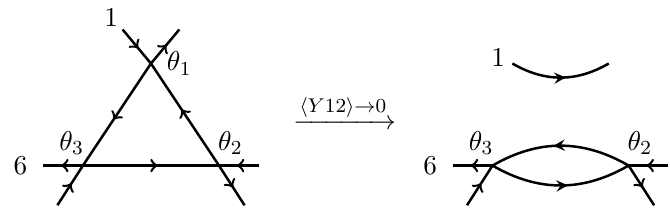
Figure 5. The diagram shows the soft limit of a six-point diagram, h Y 12 i → 0 , which corresponds to taking θ 1 → π/ 2 on the diagrams (a) or (b) in figure 2, here we show the case for diagram (a).